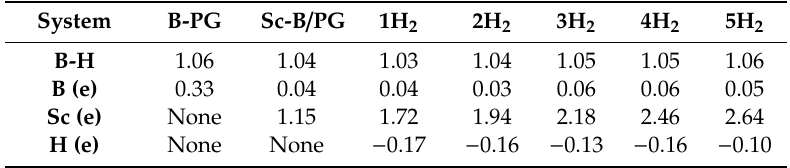
Table 3. Calculated Bond Population of the B-H bond and Mulliken Charge Population of B, H, Sc atoms in B-PG, Sc-B / PG and H 2 adsorbed Sc-B / PG